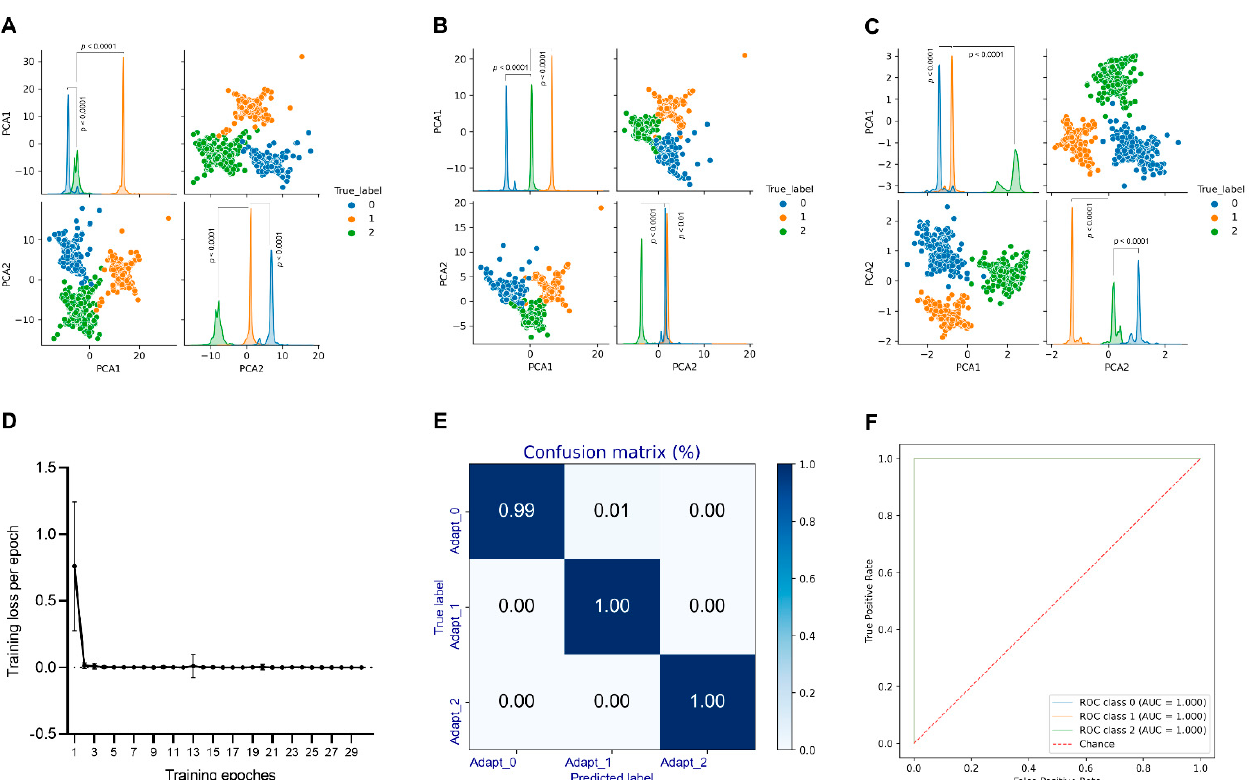
10 of 16 Figure 3 . Importance of serially segmented AA clusters for three types of human adaptation of SARS-CoV-2 variants. Normalized dot product value of AA sites in Spike genes between adaptation 0 and adaptation 1 ( A ), adaptation 0 and adaptation 2 ( B ), adaptation 1 and adaptation 2 ( C ), adaptation 0 and Omicron ( D ), adaptation 1 and Omicron ( E ), and adaptation 2 and Omicron ( F ). 3.4. Performance of the Deep Learning Model to Predict SARS-CoV-2 Adaptation To assess the ability of SARS-CoV-2 variants of Omicron sublineages to spread throughout a population, we built a CNN model based on the AA frequency vector at each AA site in Spike CDS, with training/validating data of Iota, Epsilon, Gamma (adaptation label of 0 for low adaptation), Alpha (adaptation label of 1 for a middling degree of adaptation), and Delta (adaptation label of 2 for high adaptation). To evaluate the training effect of CNN, we output the data of full-connected layers and PCA was performed to visualize the distribution of these data in the space with three adaptation labels. A lesser classification of the three groups of sequences was observed post 10 training epochs (Figure 4A), without a clear separation between adaptation 0 and 2 in